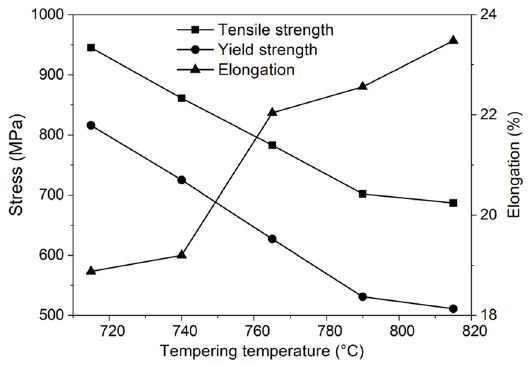
Figure 7. Tempering temperature dependence of the RT tensile properties of the T92 heat-resistant steel.